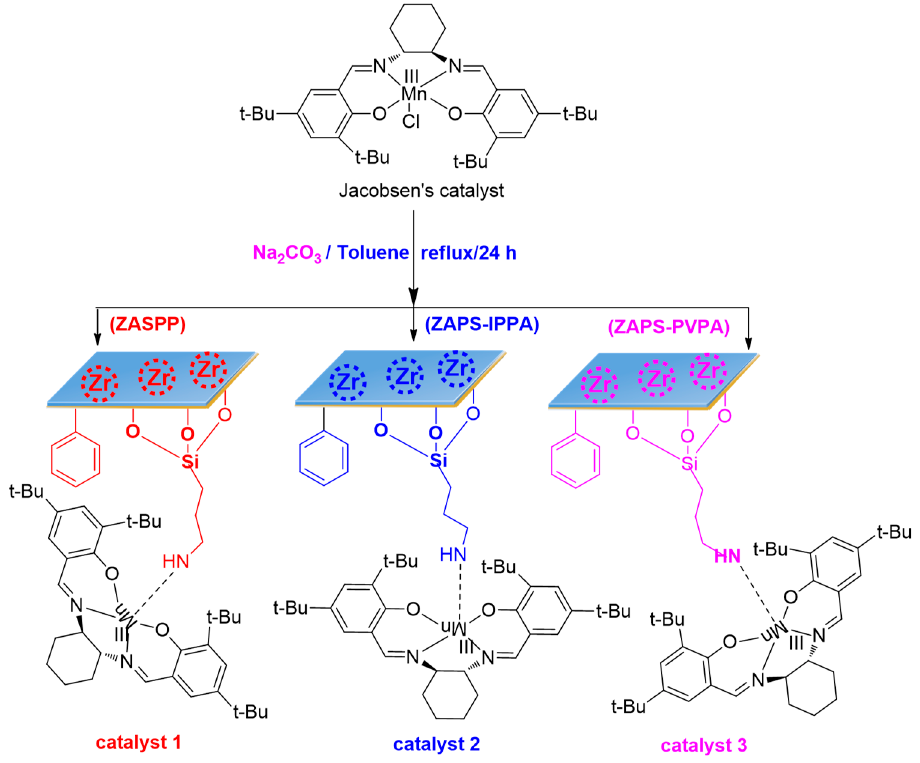
Scheme 4. Synthesis of the immobilized